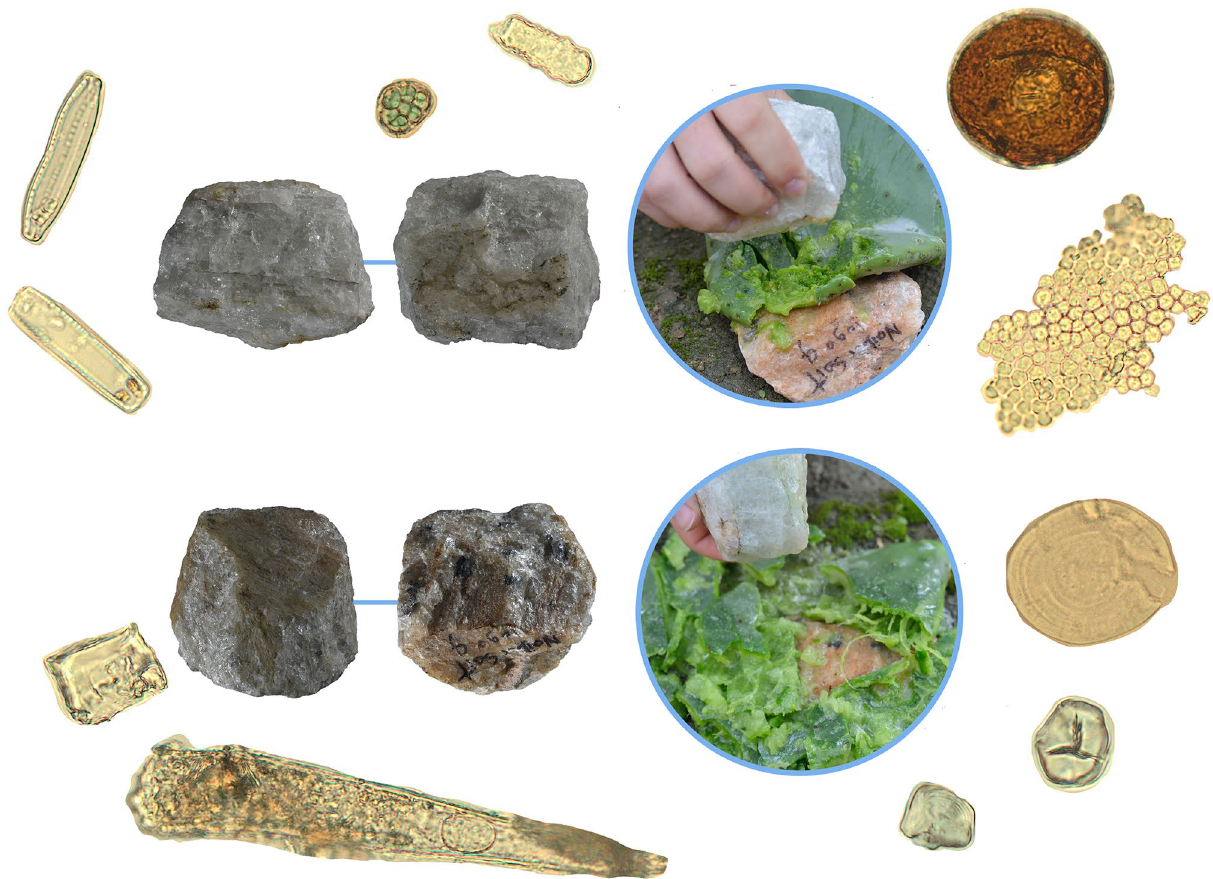
Figure 3. Vignette of microbotanical palimpsest amassed during utilization of Naibor Soit quartzite to smash cactus cladode. Center-left, shows the experimental tool’s two main facets, active and passive, while the center right shows images of the pounding process itself. All around these panels, there are microbotanical particles drawn to scale. For reference, the top right spore (dark brown globular) measures ~ 50 microns in diameter. Clockwise, epidermal tissue; similar to other pieces observed in situ (cf. Fig. 2). Known environmental contaminants include Triticeae lenticular starches and orthogonal granules from maize (T-shape centric fissures). Starch granule from cactus pulp. Phytoliths from Oldupai Gorge include large hair and bulliform cells: bottom and corner left. Diatoms, also from Oldupai Gorge, are in the upper left corner. Lastly, in the top center there are a non-pollen palynomorph and a